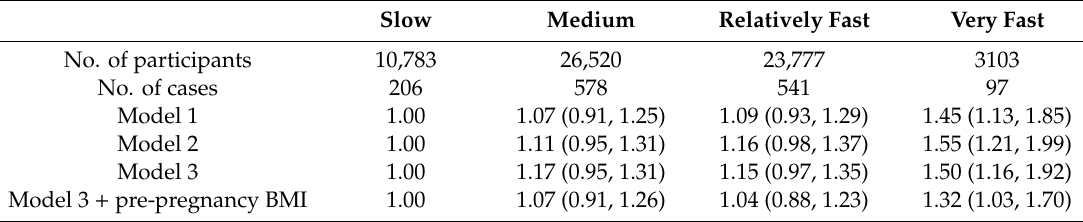
Table 3. Self-reported eating speed and risk of gestational diabetes mellitus among 64,183 women who reported the same eating speed during early and mid-late pregnancy. Slow Medium Relatively Fast Very Fast